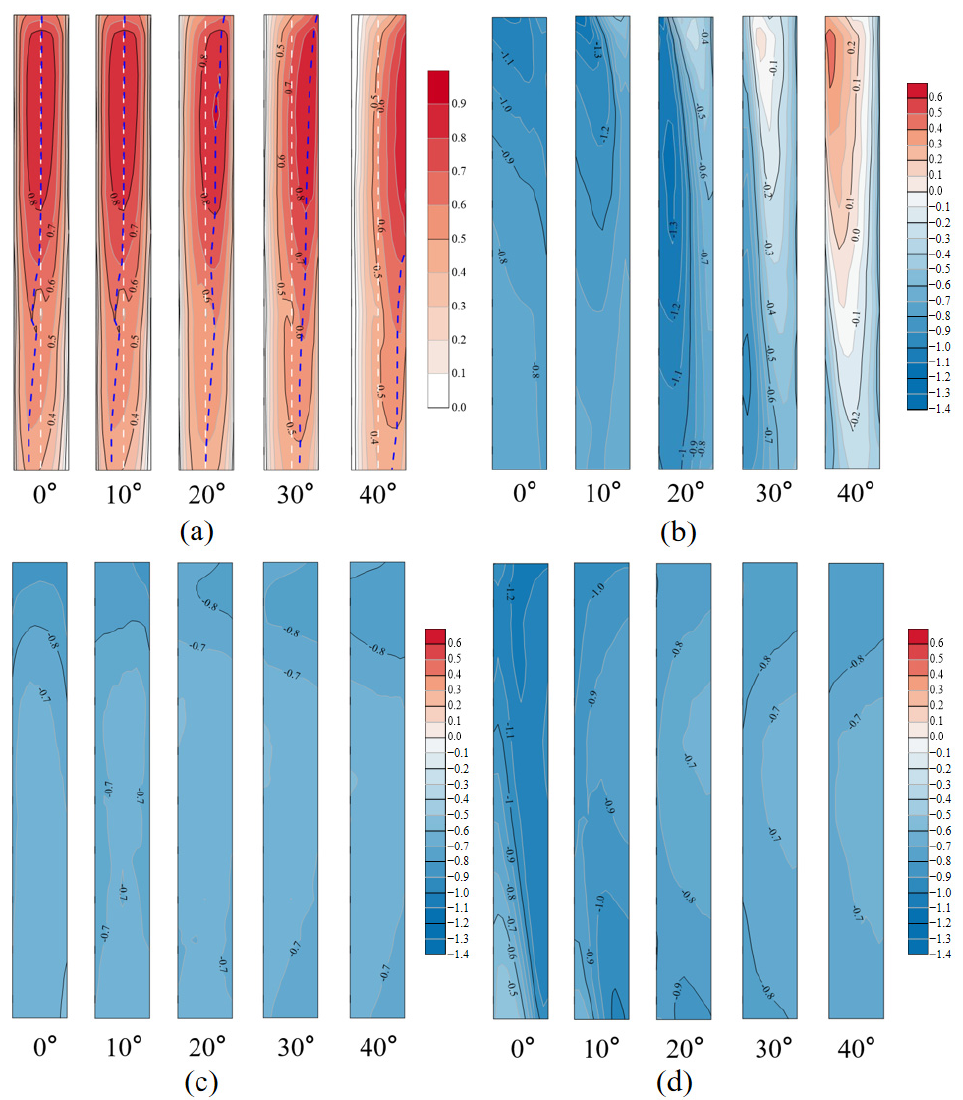
Figure 8. Distributions of C p in TWF20: ( a ) Windward facade; ( b ) Right facade; ( c ) Leeward facade; and ( d ) Left facade.